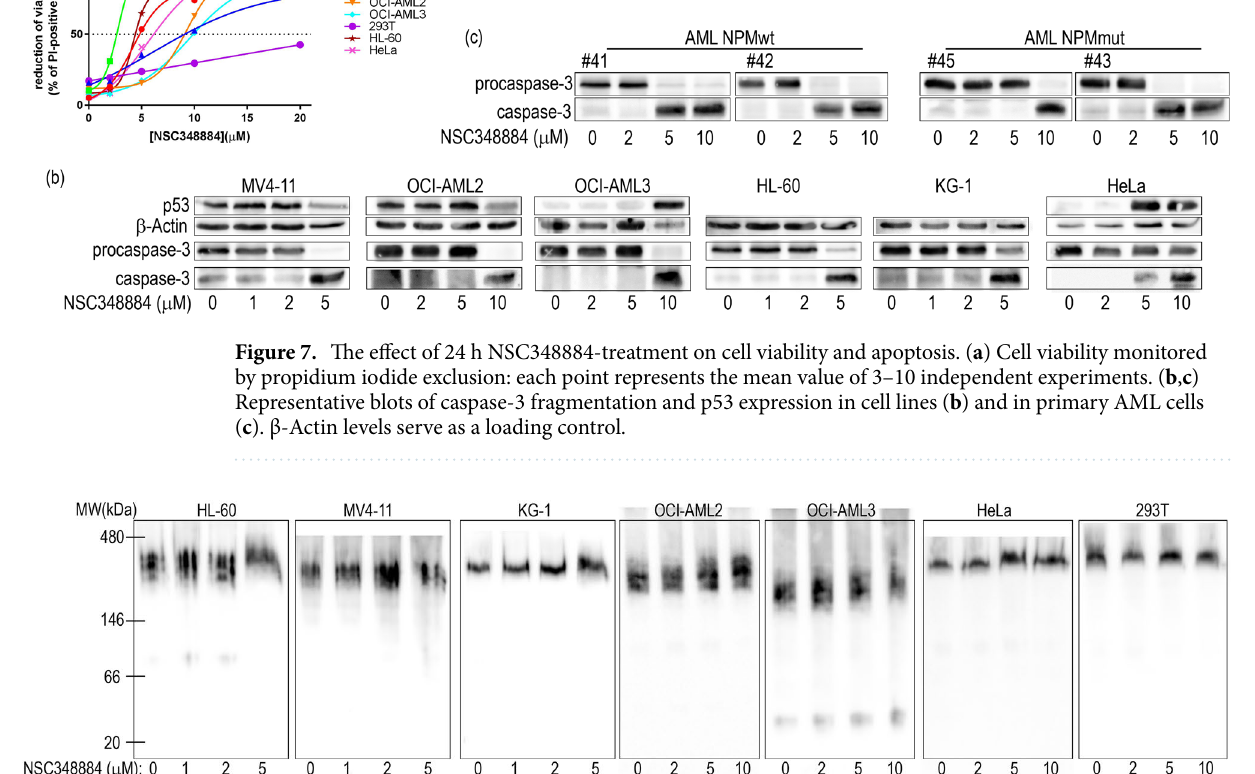
Figure 8. Effect of NSC348884 treatment on NPM oligomerization in leukemia cells. Native PAGE, representative blots: effect of 24 h NSC348884 treatment on NPM oligomerization in various leukemic cell lines as well as in adherent HeLa and 293T